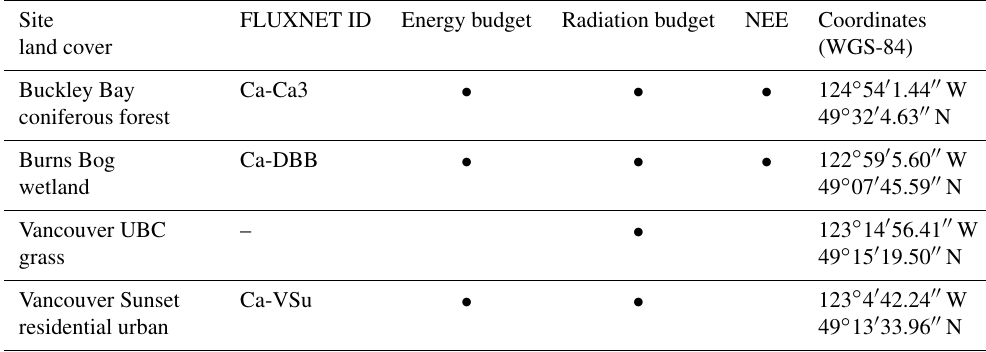
Table 1. Measurements and site characteristics (bullets indicate